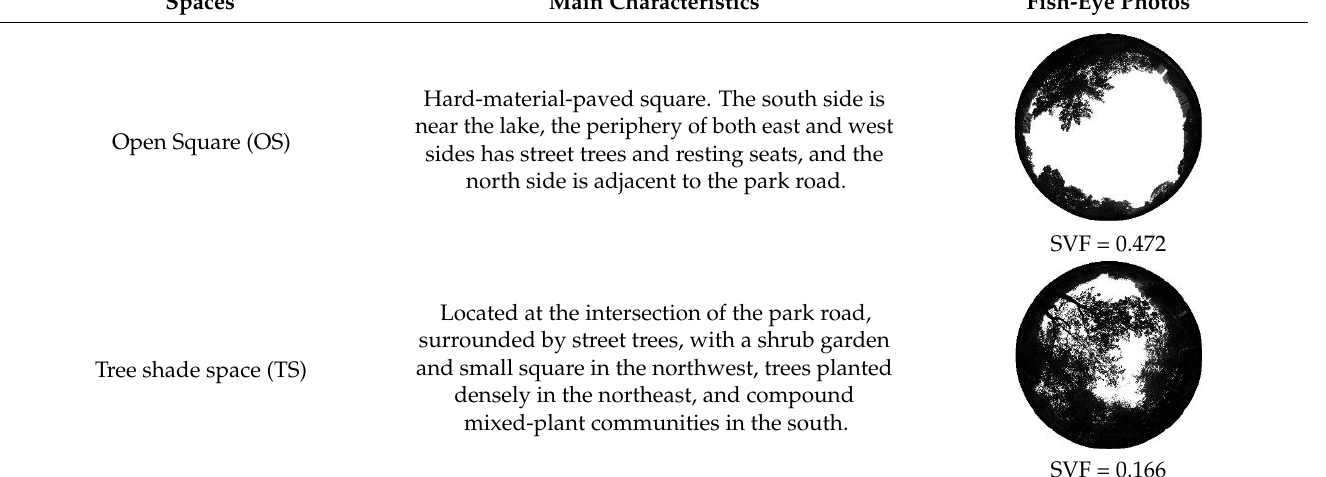
Figure 1. Site locations and measured spaces. Table 1. Descriptions of the three open spaces.